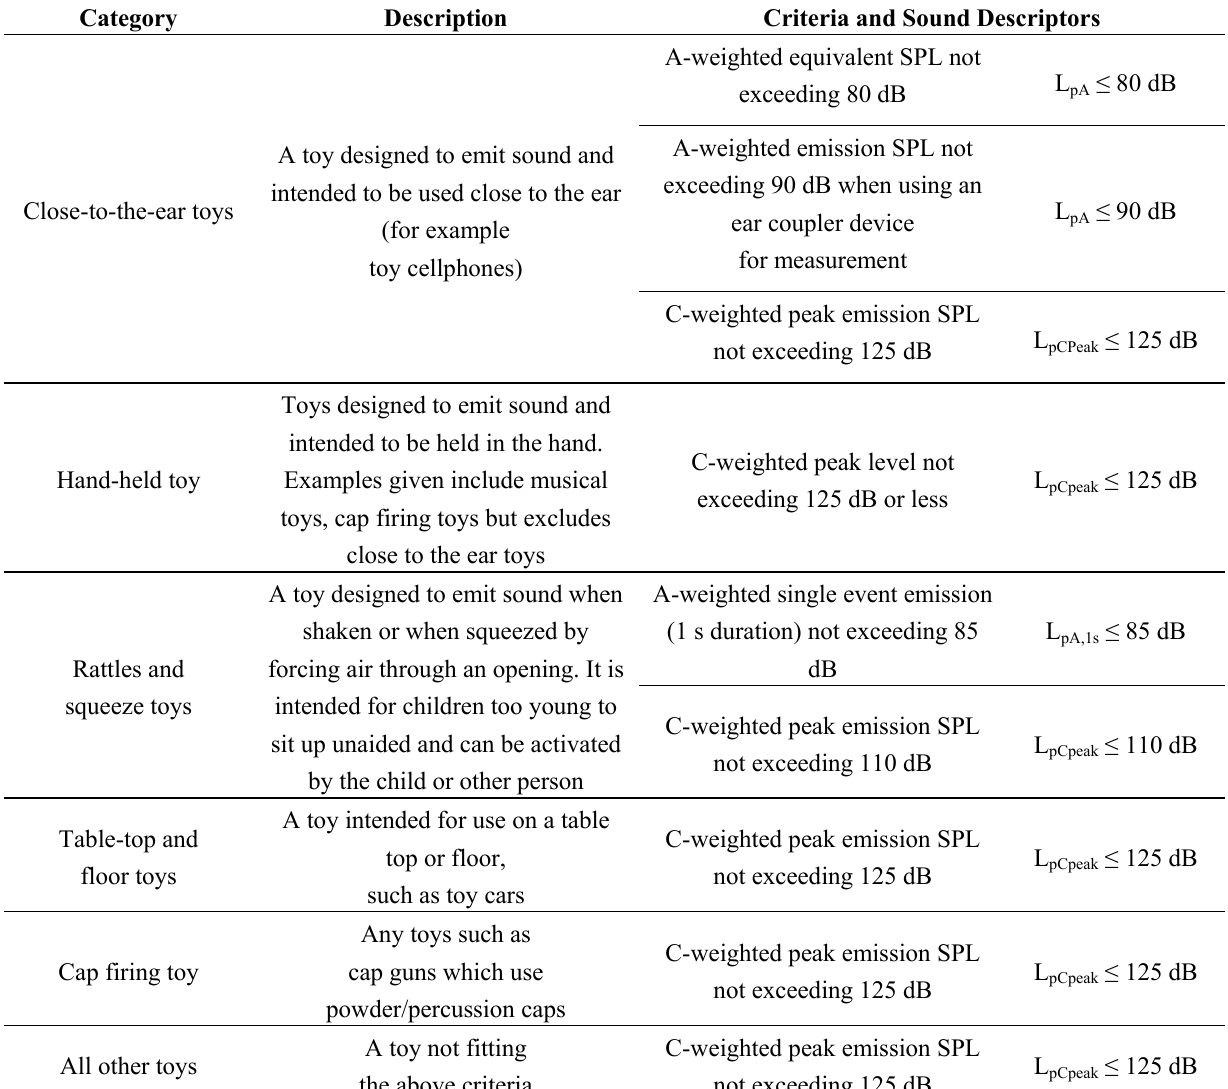
Table 1. Toy categories and criteria of the AS/NZS ISO 8124.1:2002 standard.